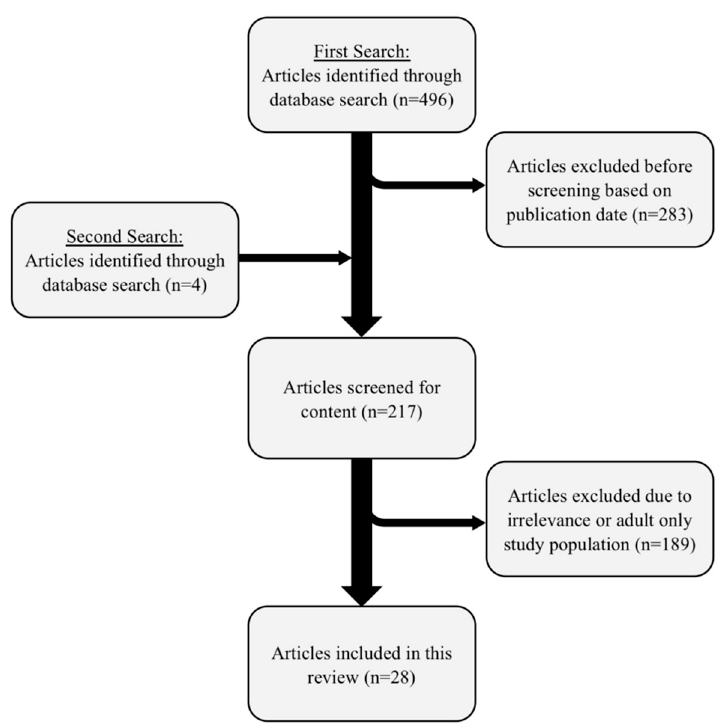
Figure 1. Graphic display of literature search using the electronic database Pubmed in accordance with the Preferred Reporting Items for Systematic Reviews and Meta-Analyses (PRISMA) method- ology.